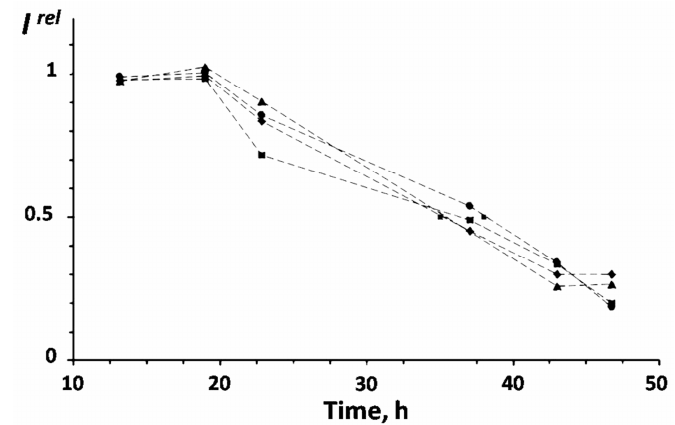
Figure 7. Kinetics of bioluminescence intensity ( I rel ) of Photobacterium phosphoreum under exposure to gamma radiation, 137 Cs, 20 °C. The error for I rel was 10%. (Dose rates: − 4100; − 1040, − 460, − 150 µGy/h.